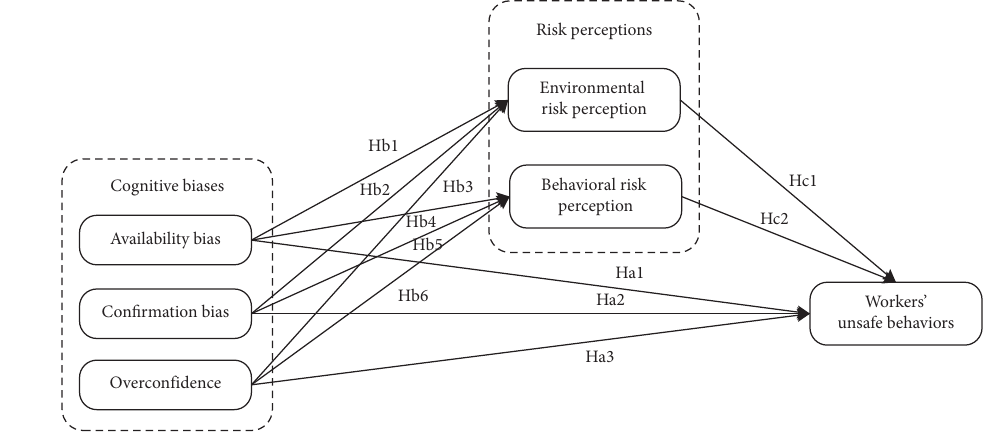
Figure 1: The hypothesized conceptual framework. Table 1: Measurement items for CBs, RPs, and WUBs. Measurement